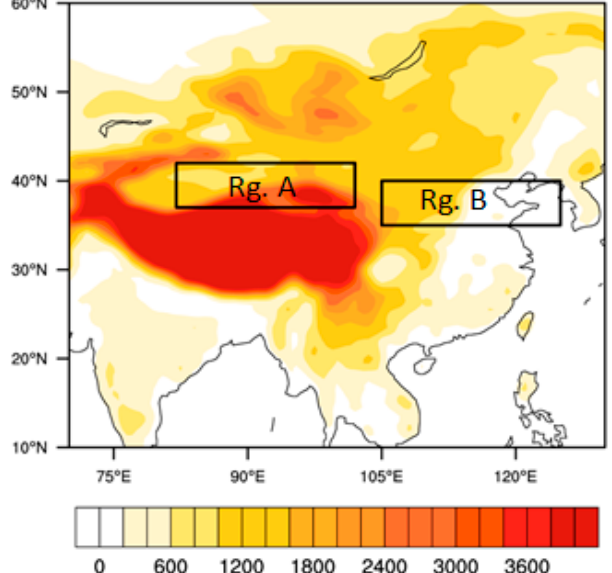
Figure 1. Details of study area domain and locations of the two regions (i.e., Rg. A and Rg. B) in China. The shading indicates terrain elevation in meters while the boxes show the longitudinal and latitudinal extents of the selected